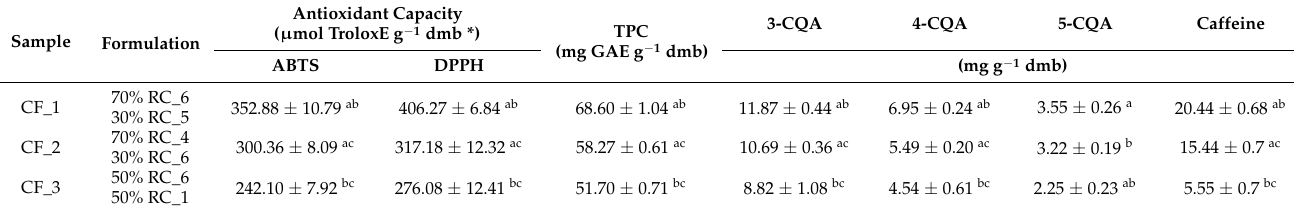
Table 8. Bioactive composition of coffee blend (CB)